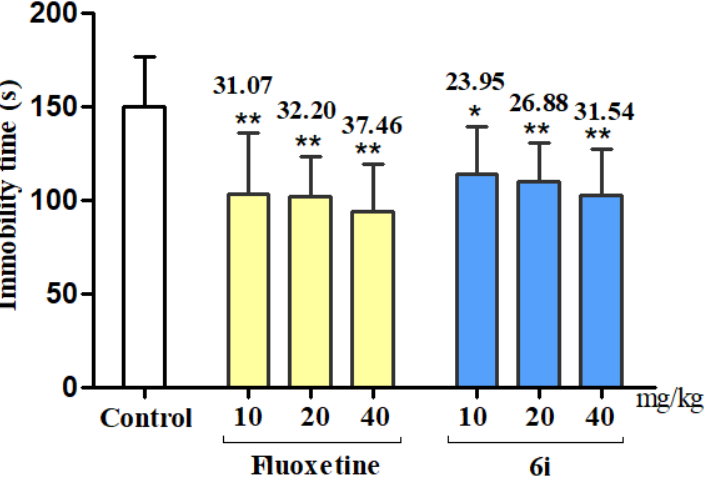
Figure 2. Antidepressant activities of compounds 6i and Fluoxetine in FST at different doses. Com- pound 6i and Fluoxetine were administered at 40, 20, and 10 mg/kg, respectively. Values represent the mean ± SEM ( n = 8). * Significant compared to control (0.01 < p < 0.05). ** Very significant compared to control ( p <